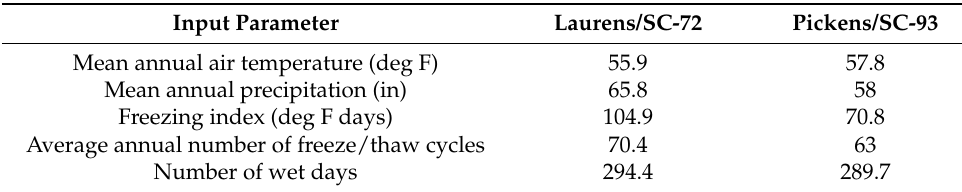
Table 2. Summary of climate data.